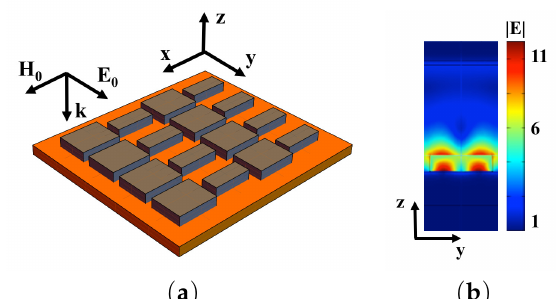
Figure 20. ( a ) silver nanodisks (small blue spots) deposited on dielectric (CeO 2 , n = 2.3) cuboids (dark red) which are placed on silver substrate (blue); ( b ) Raman enhancement G as function of wavenumber; ( c ) distribution of local electric field | E / E 0 | around silver nanodisk with a wavelength of the incident light of λ = 785nm. Geometric parameters: elementary sell sizes are D x = 650nm and D y = 550nm (light blue in ( a ); cuboid dimensions are d x = 585nm, d y = 495nm , and height h = 47nm (dark red), diameter of silver nanodisk d c = 21nm and heght h c = 3nm , aspect ratio of the nanodisk h c / d c = 1/7, distance between nanodisks ≈ 60nm (from [17]).